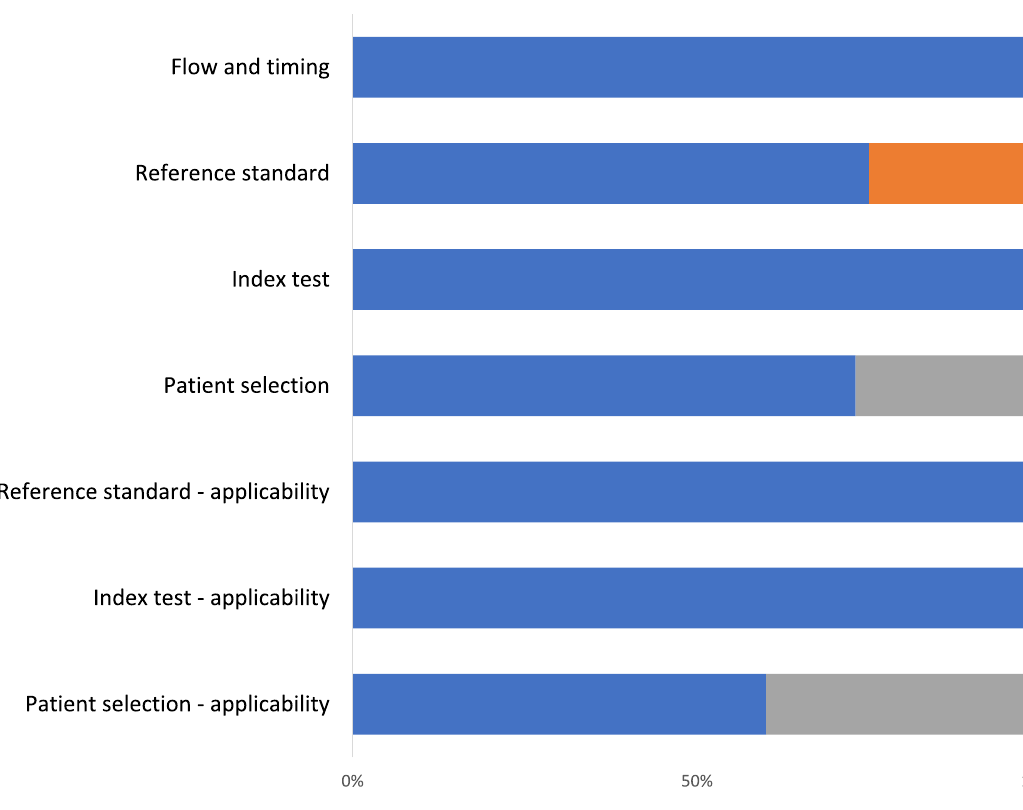
Figure 2. Quality assessment of diagnostic accuracy studies 2 (QUADAS-2) finding per domain for included studies in the systematic review. Blue represents low level of bias, grey represents high level of bias, while orange represents unclear level of